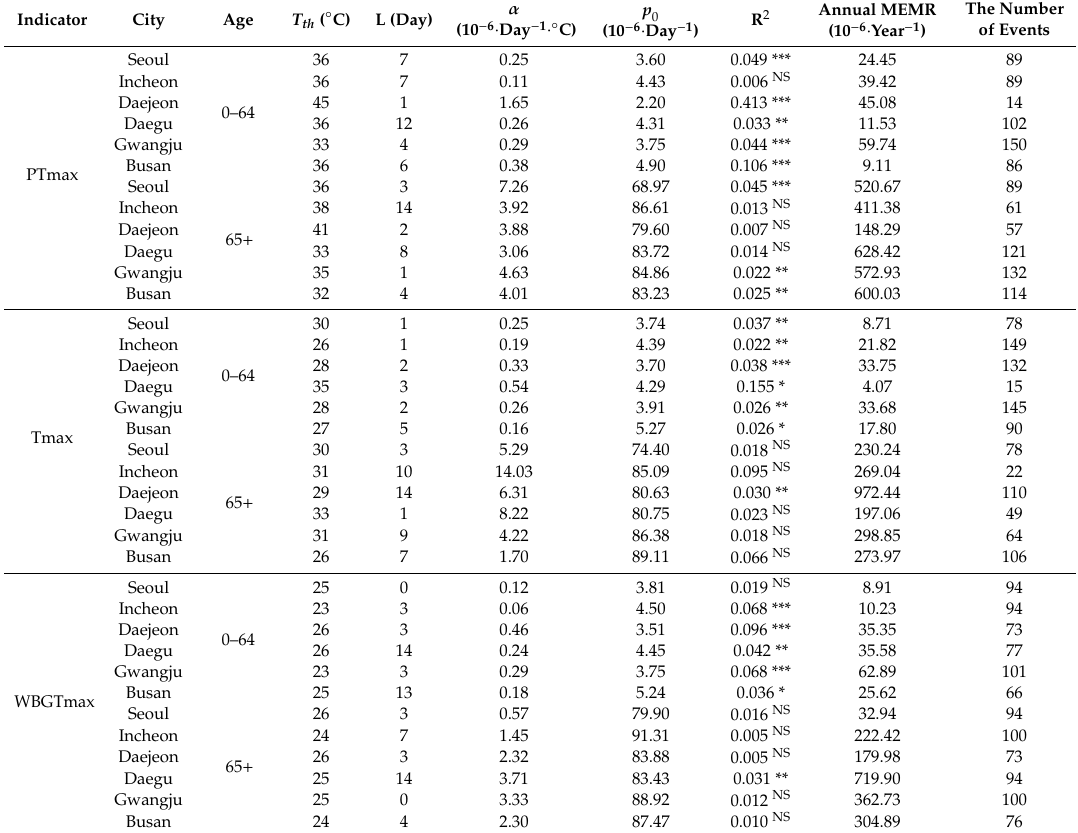
Table 4. Free parameters, coe ffi cient of determination, and annual mean excess mortality rate (MEMR) of the fitted heat-related risk assessment model depending on regions and ages for the training period